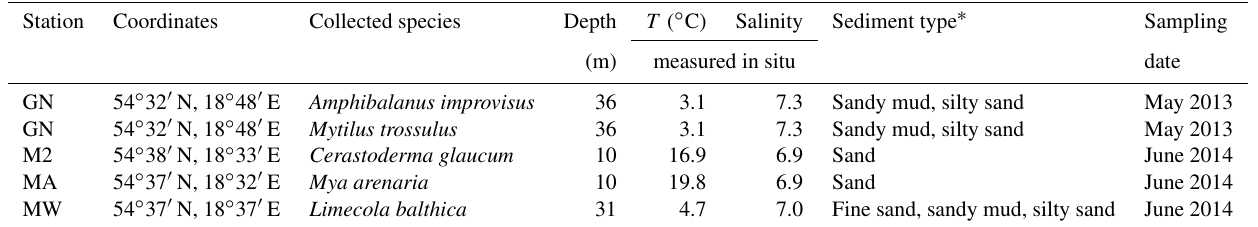
Table 1. Details of the sampling locations. Temperature ( T ) and salinity were measured near the bottom during sample collection. Station Coordinates Collected species